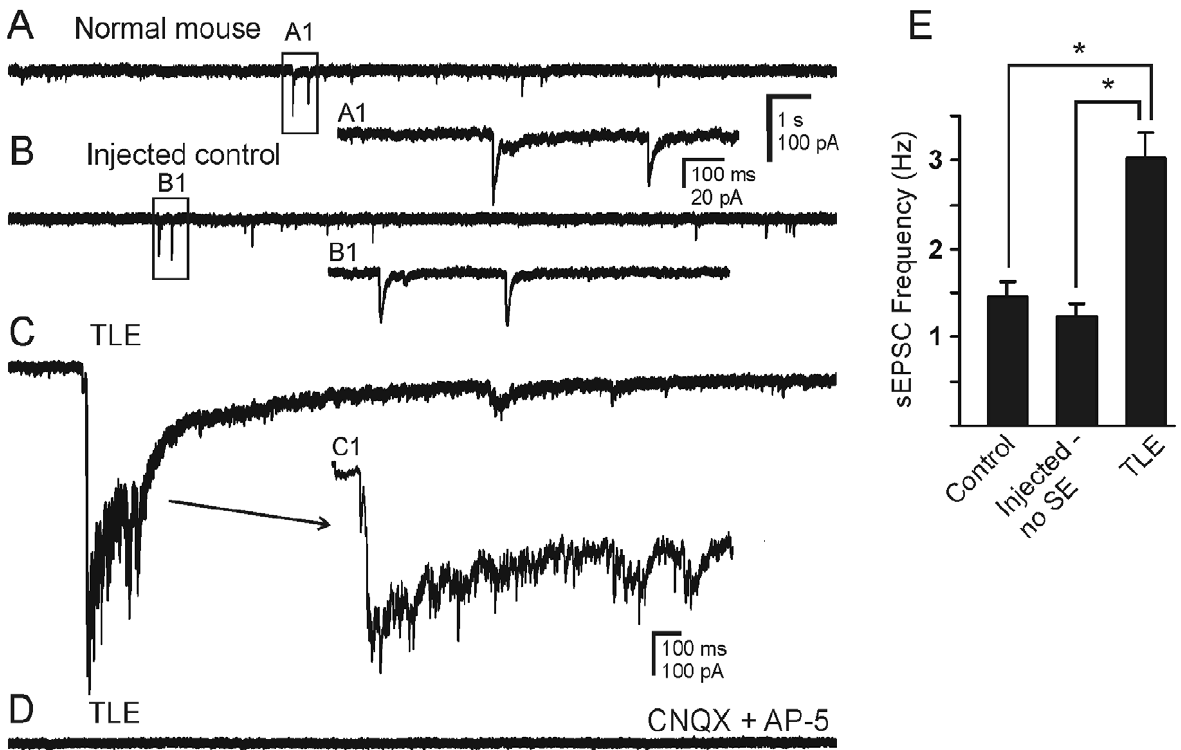
Figure 2. Increase in synaptic activity in granule cells from pilocarpine-treated mice that survived SE and developed TLE. A . sEPSCs recorded from granule cell of normal mouse. B . sEPSCs recorded from granule cell of a mouse that was injected with pilocarpine but did not develop SE. C . sEPSCs and bursting activity recorded from a granule cell of a pilocarpine-treated mouse that developed TLE. D . Trace showing that sEPSCs were blocked by application of ionotropic glutamate receptor antagonists, CNQX (10 m M) and AP-5 (50 m M). A1 and B1 are expanded boxed regions of A and B . C1 , expansion of the sEPSC showing increased synaptic activity during the burst seen in C . Recordings were made in the absence of added Mg 2 + and the presence of bicuculline (30 m M). E . Bar graph comparing the frequency of sEPSCs among the three groups of animals. Asterisk indicates significantly higher frequency in cells from mice with TLE (P , 0.05).